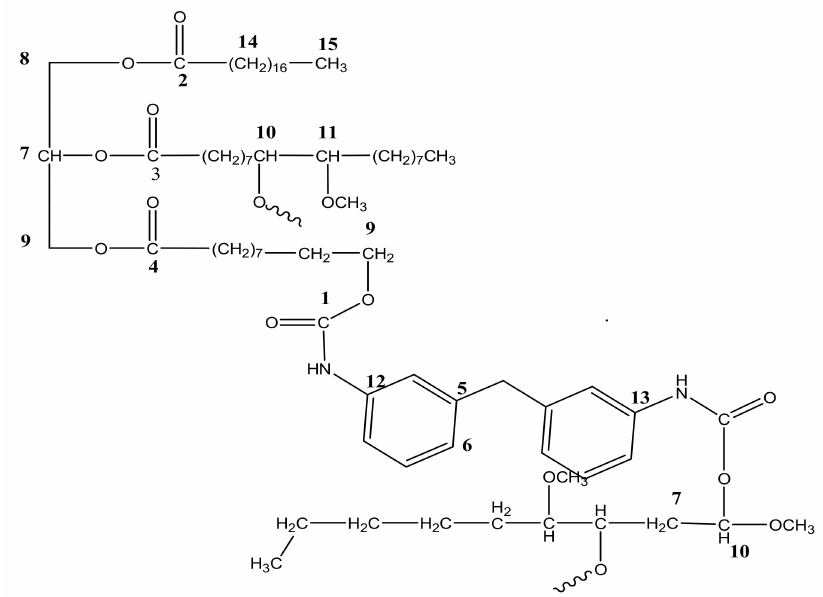
Figure 7. Chemical structure of polyurethane (PU) based on NMR spectra.